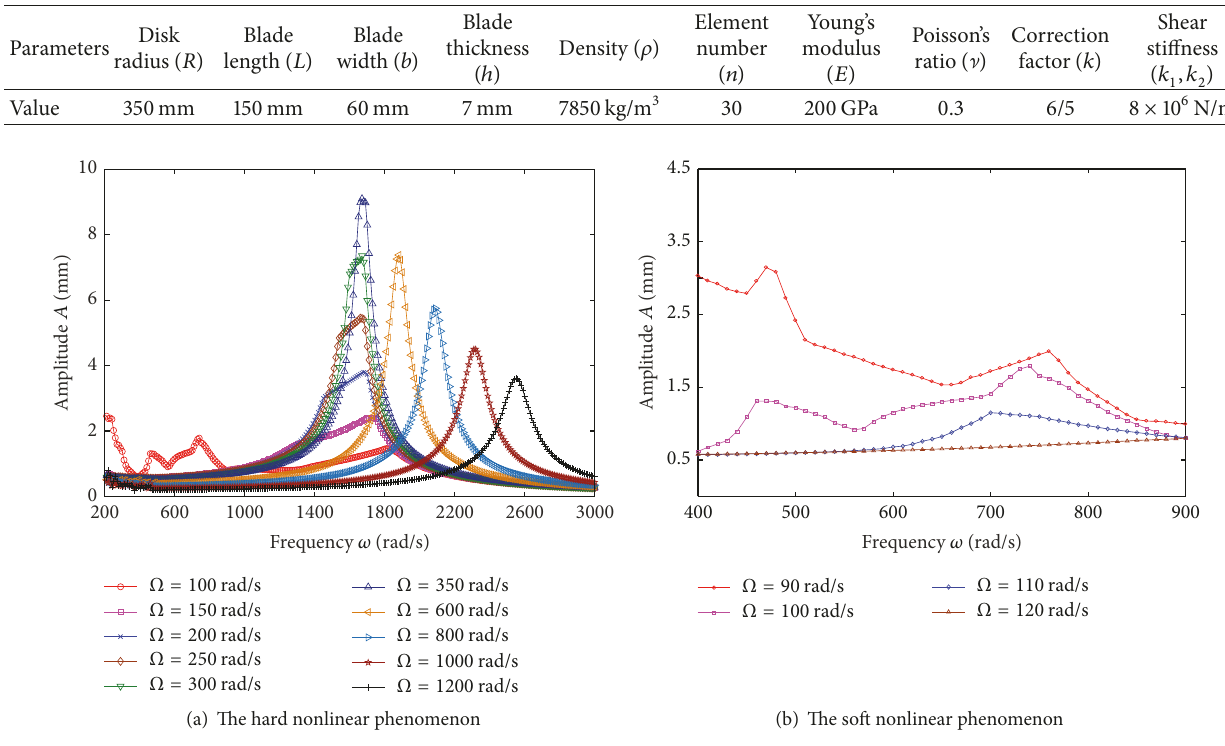
(b) The soft nonlinear phenomenon